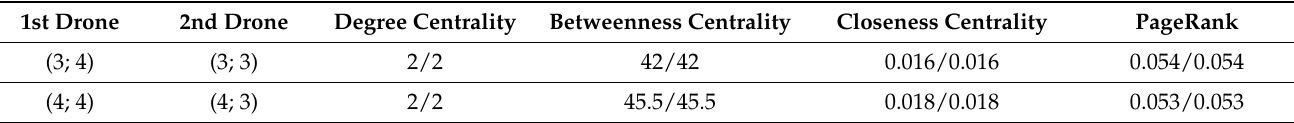
Table 2. Centrality measures computed for two optimal positions of the drones. The respective values for the first and the second drone are separated by a slash: C x ( δ 1 ) / C x ( δ 2 )